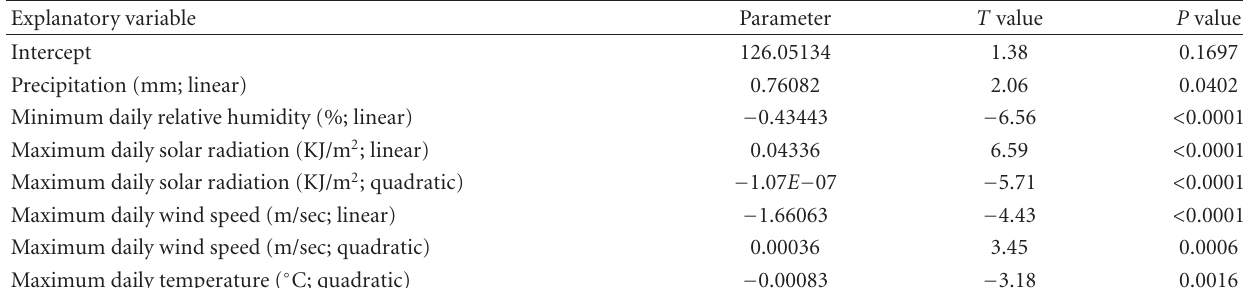
Table 2: Linear and quadratic regression analysis of weight (gram) of canola plants.